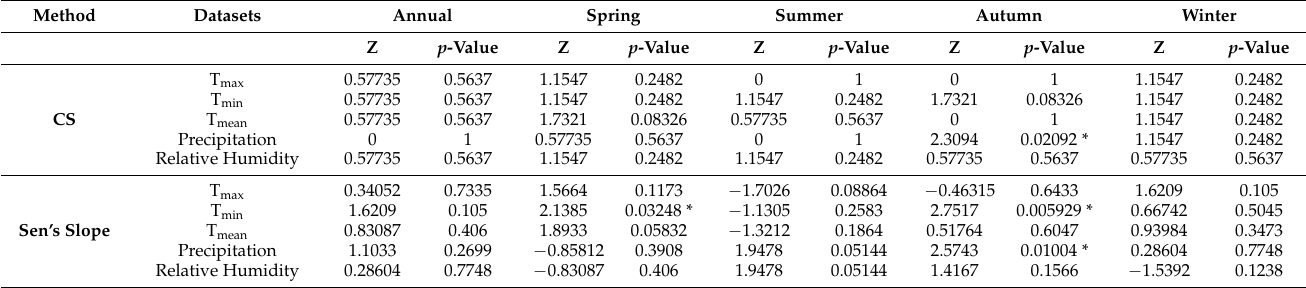
Table 5. Summary of the significance and magnitude of statistical tests of Punjab, Pakistan, over the period 1979–2014. Method